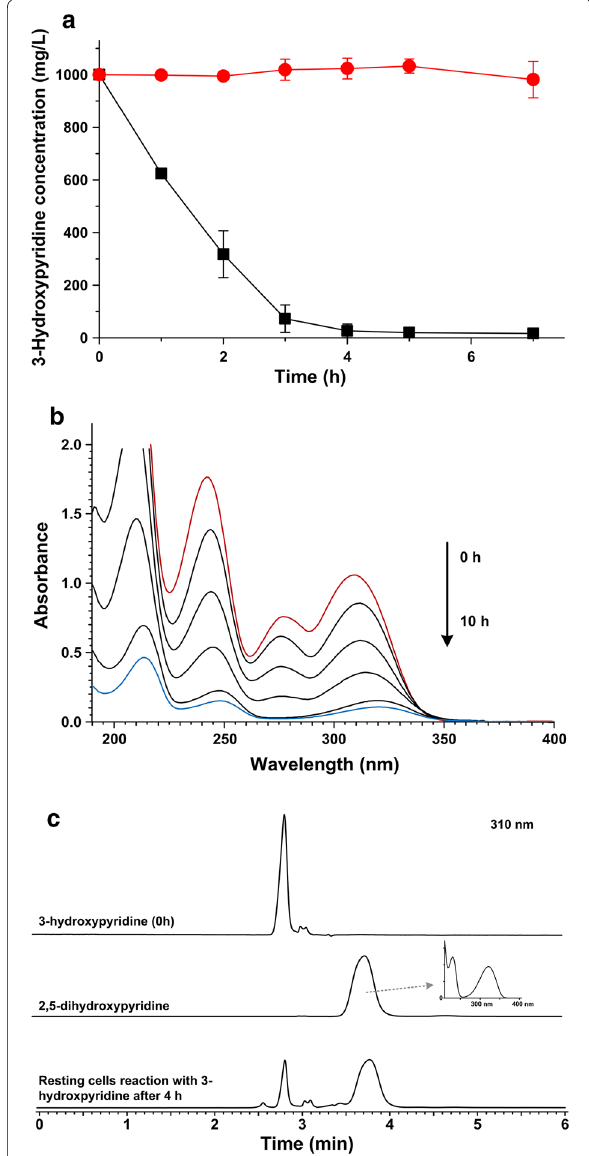
Fig. 5 Analysis of 3-hydroxypyridine degradation by resting cells of strain DW-1. a 3-Hydroxypyridine degradation by resting cells of strain DW-1 grown in MSM with 3-hydroxypyridine (black line) or MSM with glycerol NH 4 Cl (red line). b Ultraviolet spectrum scanning + of samples from resting cells reactions. c HPLC analysis of samples from resting cells